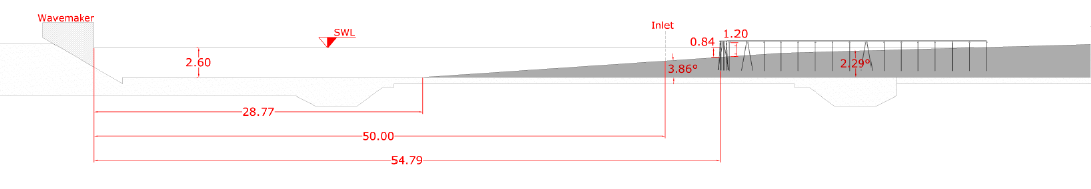
Figure 6. Sketch of the experimental layout. The 2-D numerical model mimics this layout to a great extent. Conversely, the 3-D model has an open boundary for wave generation at the inlet, i.e., at x = 50